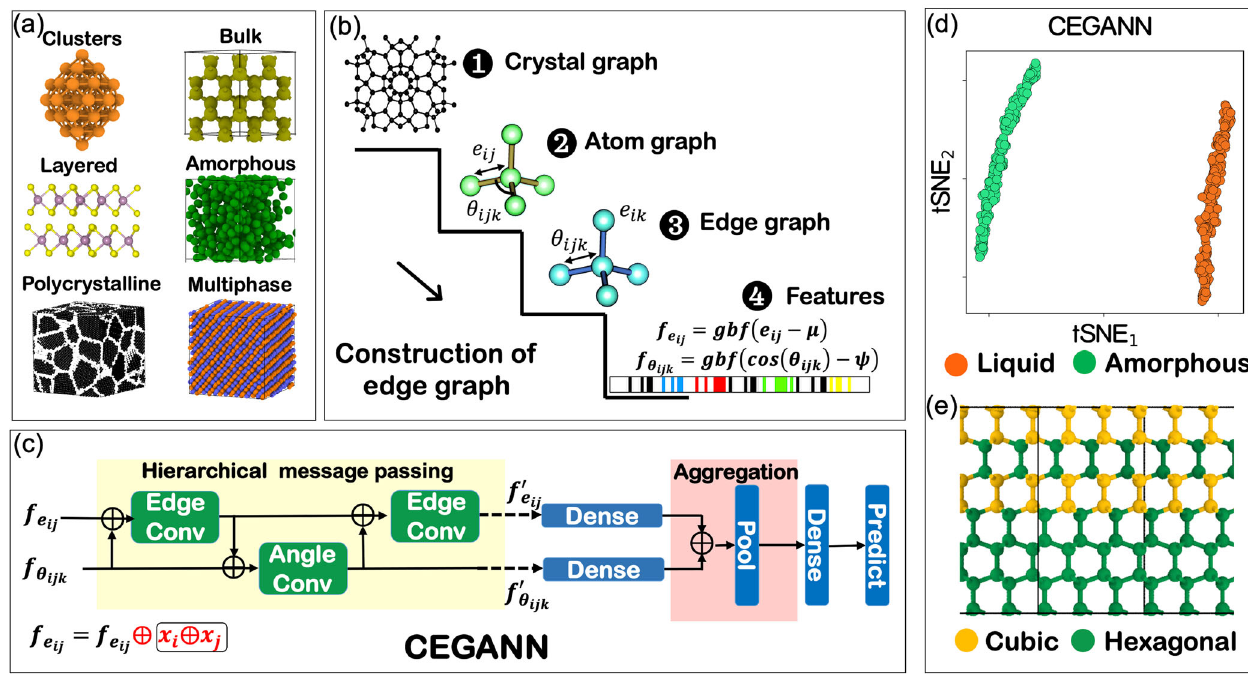
Fig. 2 Basic architecture of CEGANN work fl ow. a , b Crystals are converted into atom graphs and edge graphs are obtained from atom graphs. c Shows alternate message passing and hierarchical interaction between edge and angle convolutions. Finally, the atom feature, convolved edge, and angle features are concatenated to produce the fi nal representation. d t-SNE plot of the feature vector of liquid and amorphous structures as predicted by CEGANN work fl ow on an identical test dataset as Fig. 1. e Shows identi fi cation of particles belonging to a hexagonal and cubic motif in an ABABCB stacked ice by a trained CEGANN work fl (Fig. 2), to learn feature representation of material environments. An